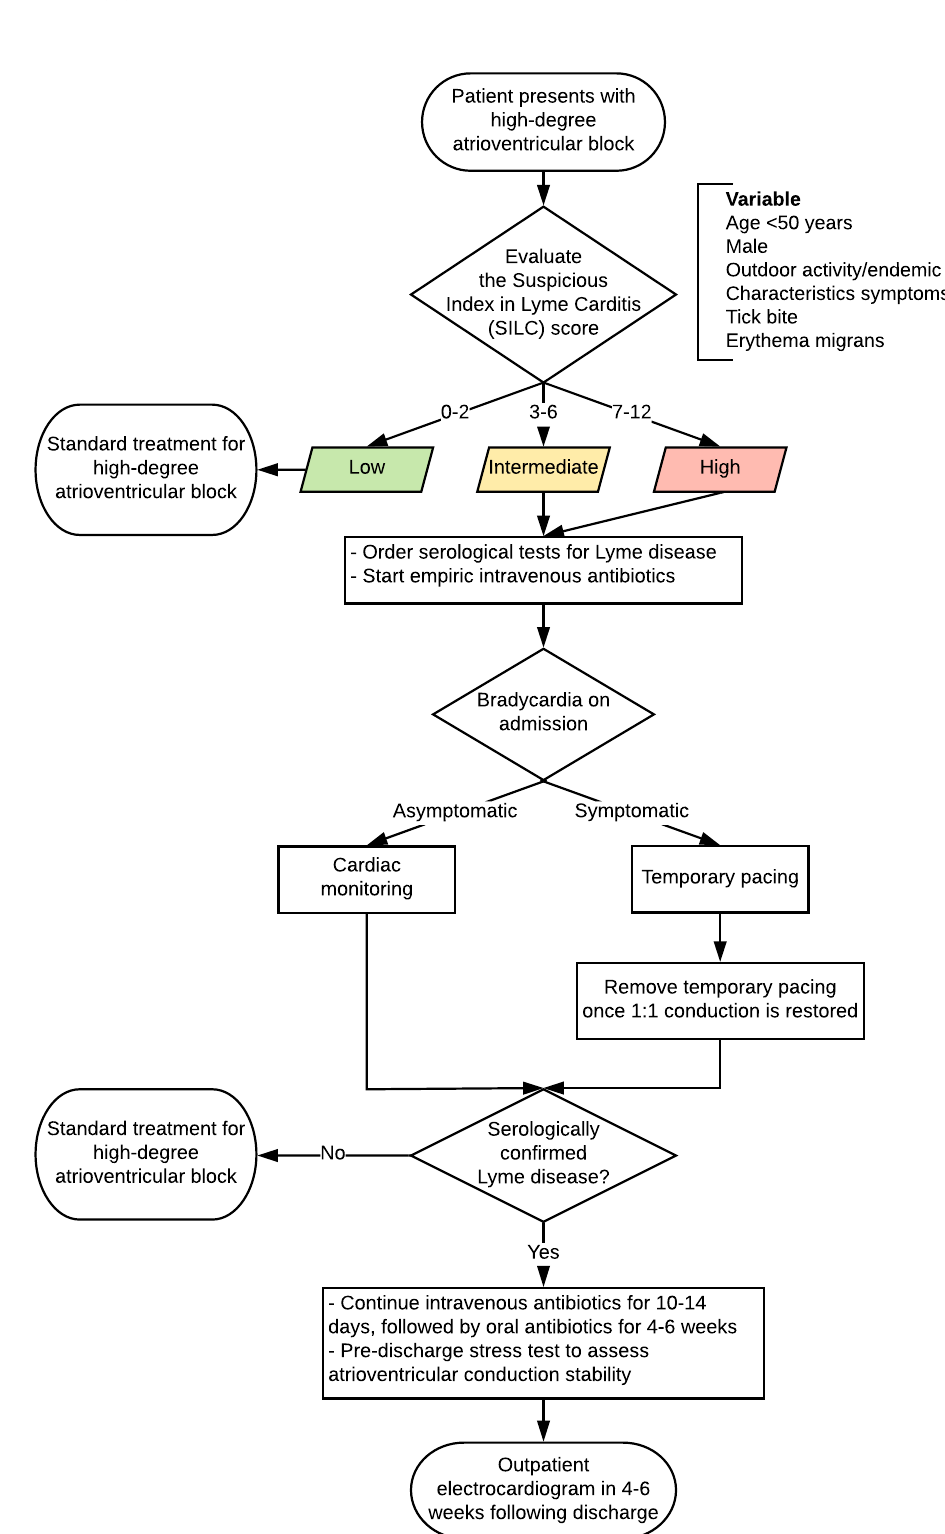
Figure 1. Systematic approach to the diagnosis and management of Lyme carditis and high-degree atrioventricular